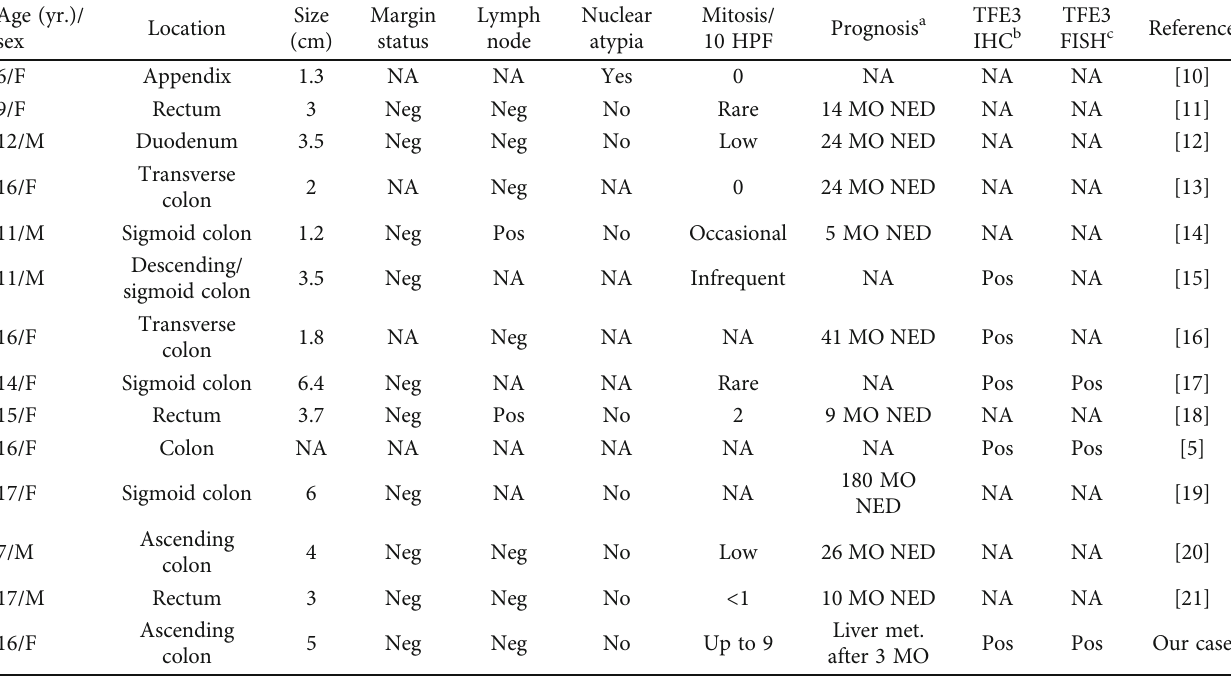
Table 1: Graph demonstrating